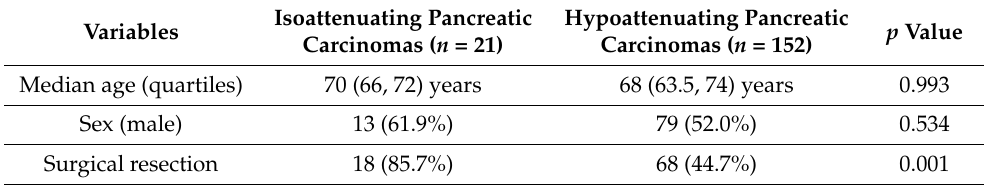
Table 2. Basic characteristics of isoatenuating and hypoattenuating pancreatic